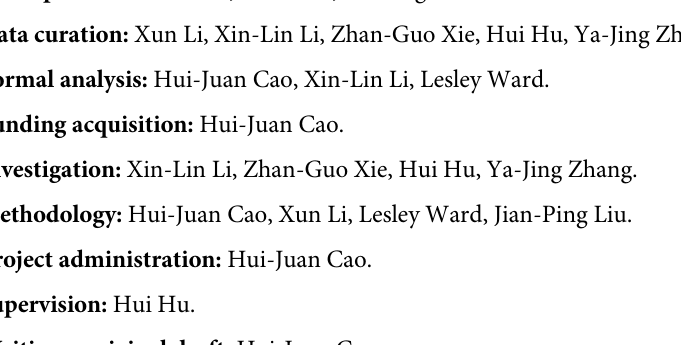
S1 Table. Consolidated criteria for reporting qualitative research (COREQ): A 32-item checklist for interviews and focus groups. S2 Table. The outline of the